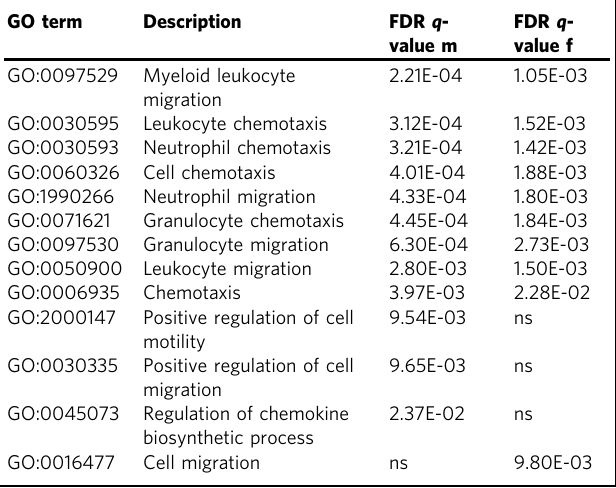
Table 1 GO terms connected with migration, chemotaxis, and